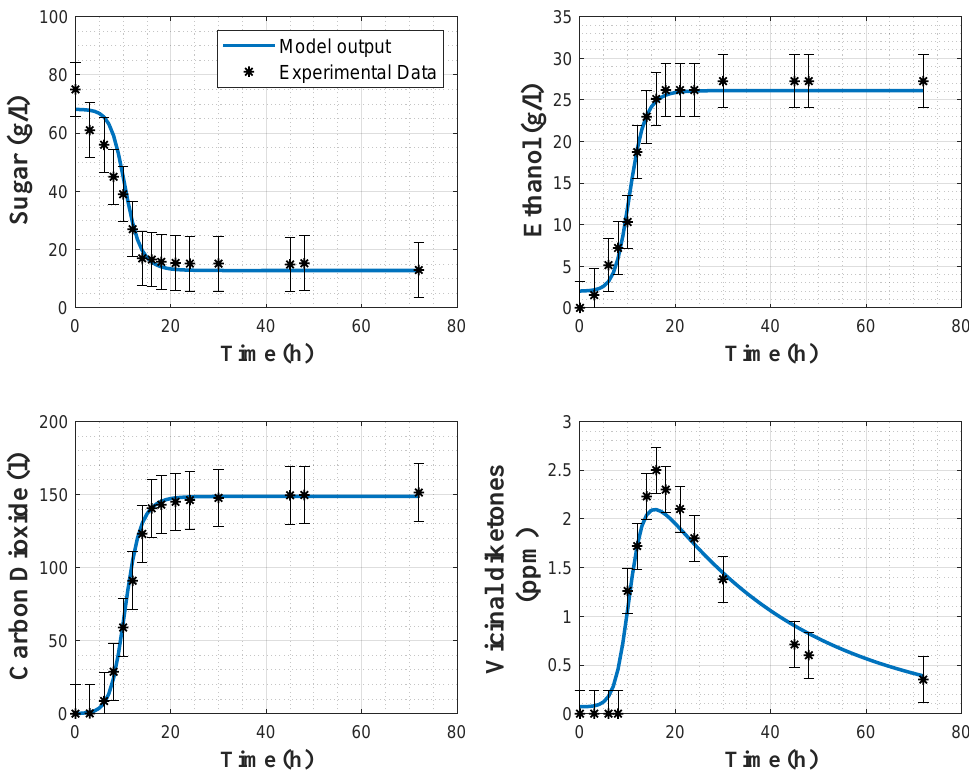
Figure 6. Direct validation of the carbon dioxide model with the data from experiment 4. Stars: experimental data. Error bars: 95% confidence intervals. Continuous blue line: model prediction. Table 6. Parameter estimate values and coefficients of variations (CV) for the carbon dioxide model.